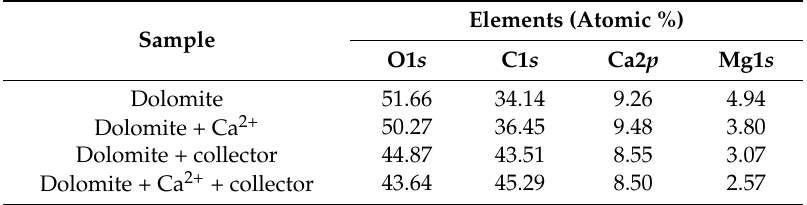
Table 3. Atomic percent of elements for dolomite surfaces in various conditions (pH = 7.0).